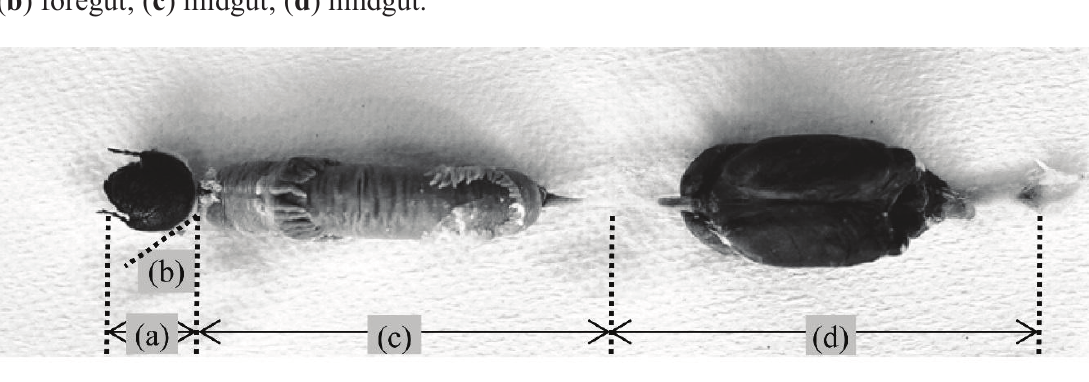
Figure 1. The larval digestive tract of the Trypoxylus dichotomus (L.). ( a ) Head; ( b ) foregut; ( c ) midgut; ( d )